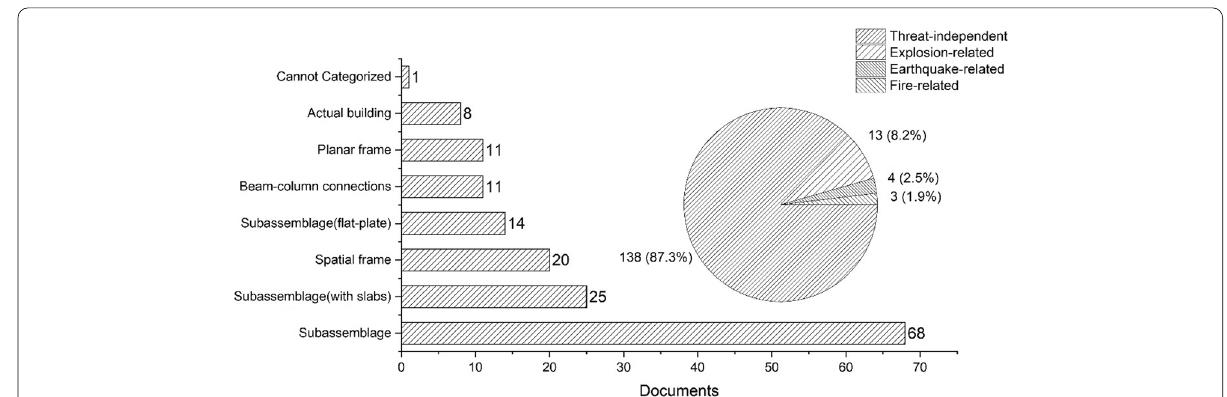
Fig. 2 Number of papers by specimen formations and threat